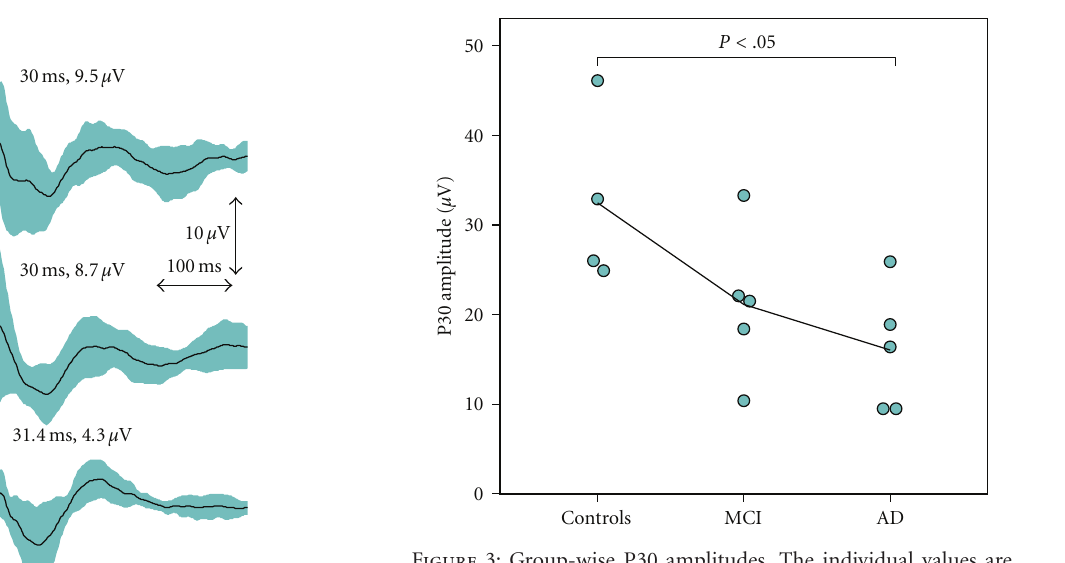
Figure 3: Group-wise P30 amplitudes. The individual values are presented as a mean value of P30 amplitude measured from both hemispheres. Black line represents the group-wise mean value when moving from controls to MCI and